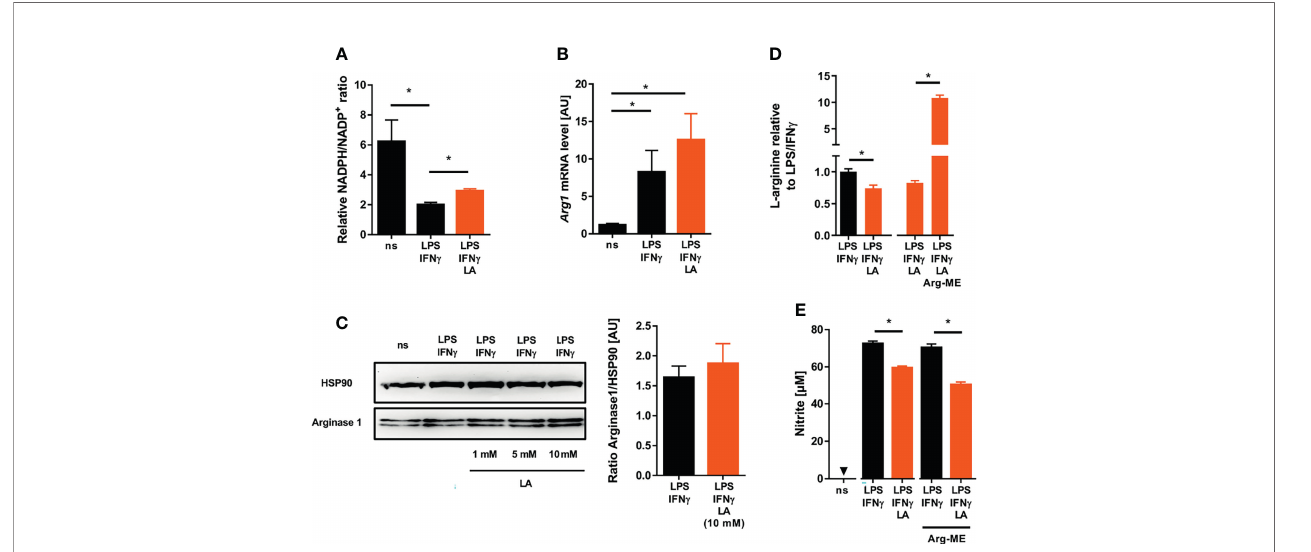
FIGURE 4 | Lactic acid-induced changes in cosubstrate availability do not underlie impaired NO production in LPS/IFN- g coactivated macrophages. (A – E) BMDM were costimulated with LPS (10 ng/mL)/IFN- g (20 ng/mL) or left untreated (ns) for 24 h. Cells were treated with 10 mM lactic acid (LA), unless indicated otherwise. (A) Relative NADPH/NADP + -ratio (mean + SEM, n = 11-12 from three independent experiments; * p < 0.05, Kruskal-Wallis test and Dunn post hoc test). (B) Arg1 mRNA levels (mean + SEM, n = 14-15 from fi ve independent experiments; * p < 0.05, Kruskal-Wallis test and the Dunn post hoc test). (C) Left panel: Arginase 1 and HSP90 protein levels (representative of six similar independent experiments). Right panel: Densitometry of Arginase 1 normalized to HSP90 protein levels after treatment with 10 mM LA (mean + SEM, n = 6 from six independent experiments; Mann-Whitney test). (D) Relative L-arginine levels (mean + SEM, n =